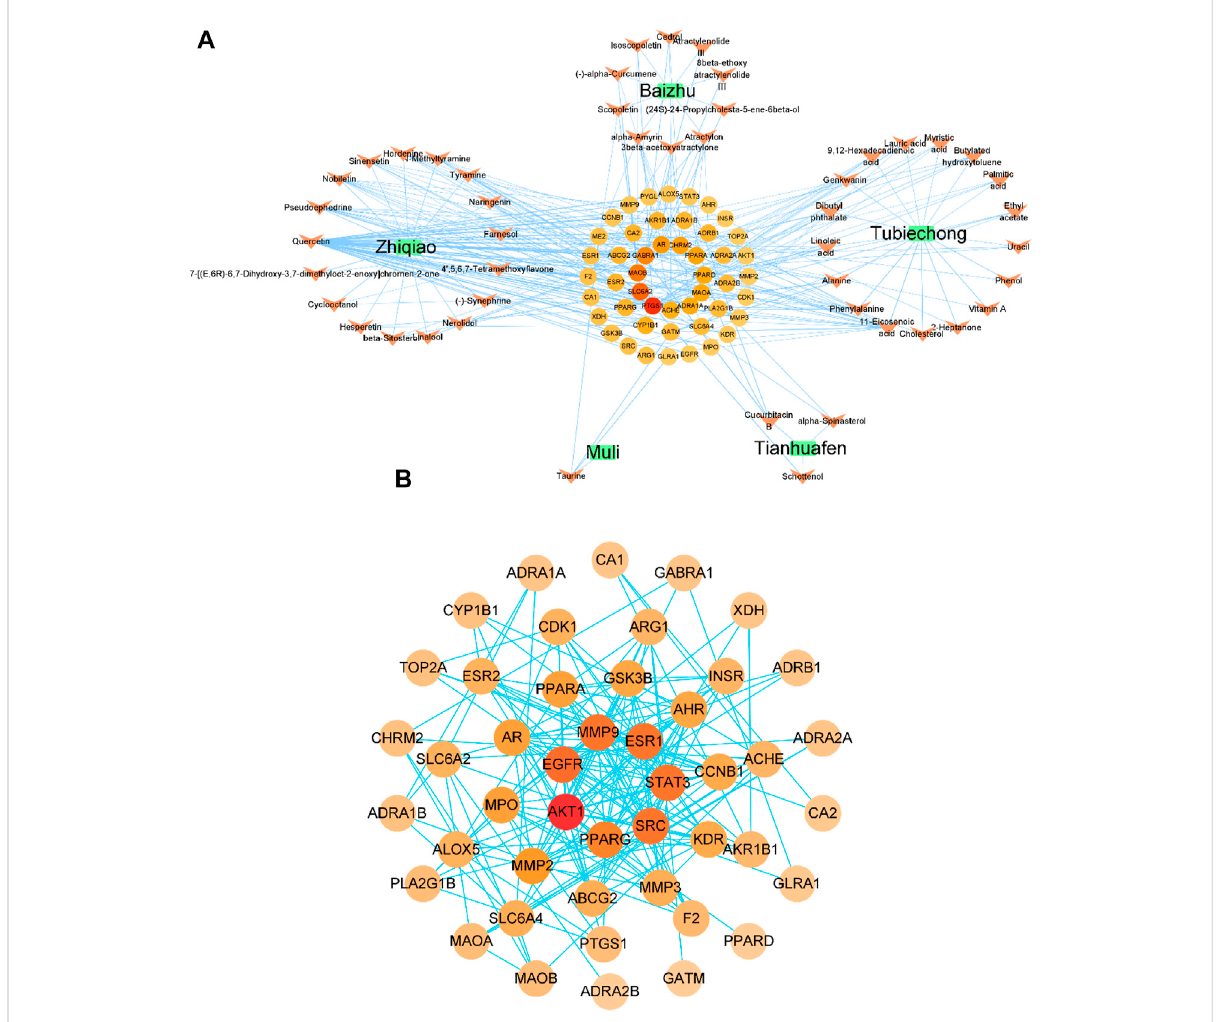
FIGURE 4 Drug-ingredient-targetgenenetworkdiagram (A) ;protein-proteininteraction(PPI)networkandcoreproteinnetwork,thecolorandsizeofthe nodes depend on the connectivity value (B)